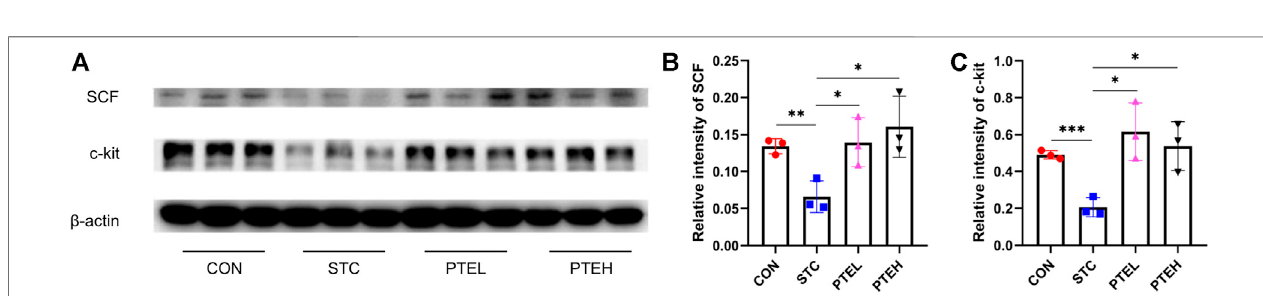
FIGURE4| Expressionsofc-kitand SCFprotein incolontissues. (A) Theexpression levels ofc-kitand SCFwereexaminedbywesternblot. Proteinquanti fi cation of the results was shown in (B,C) . n = 3.* p < 0.05, ** p < 0.01, *** p < 0.01.